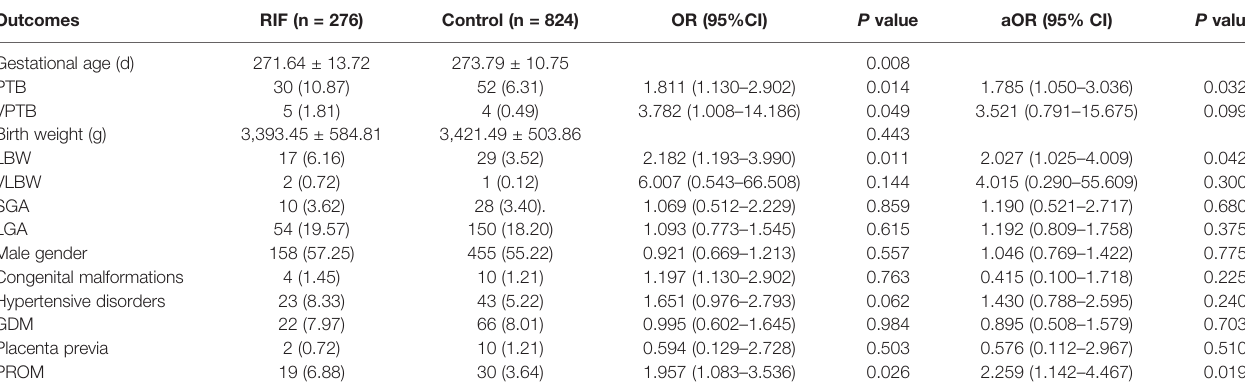
TABLE 2 | Neonatal outcomes and obstetric complications for singleton births in the RIF group versus control group. Outcomes